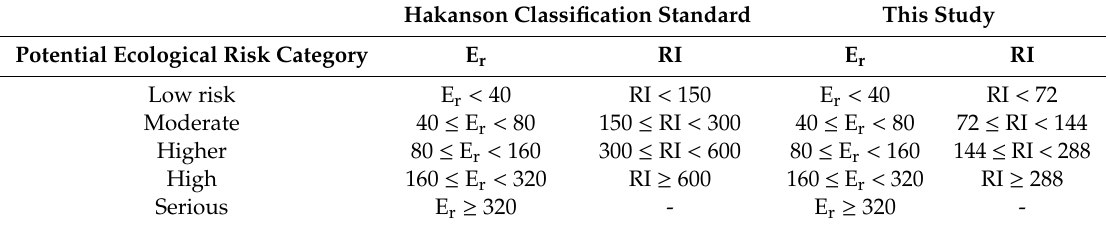
Table 3. Comparison of the Hakanson classification standard and this study’s E r and risk index (RI) grading